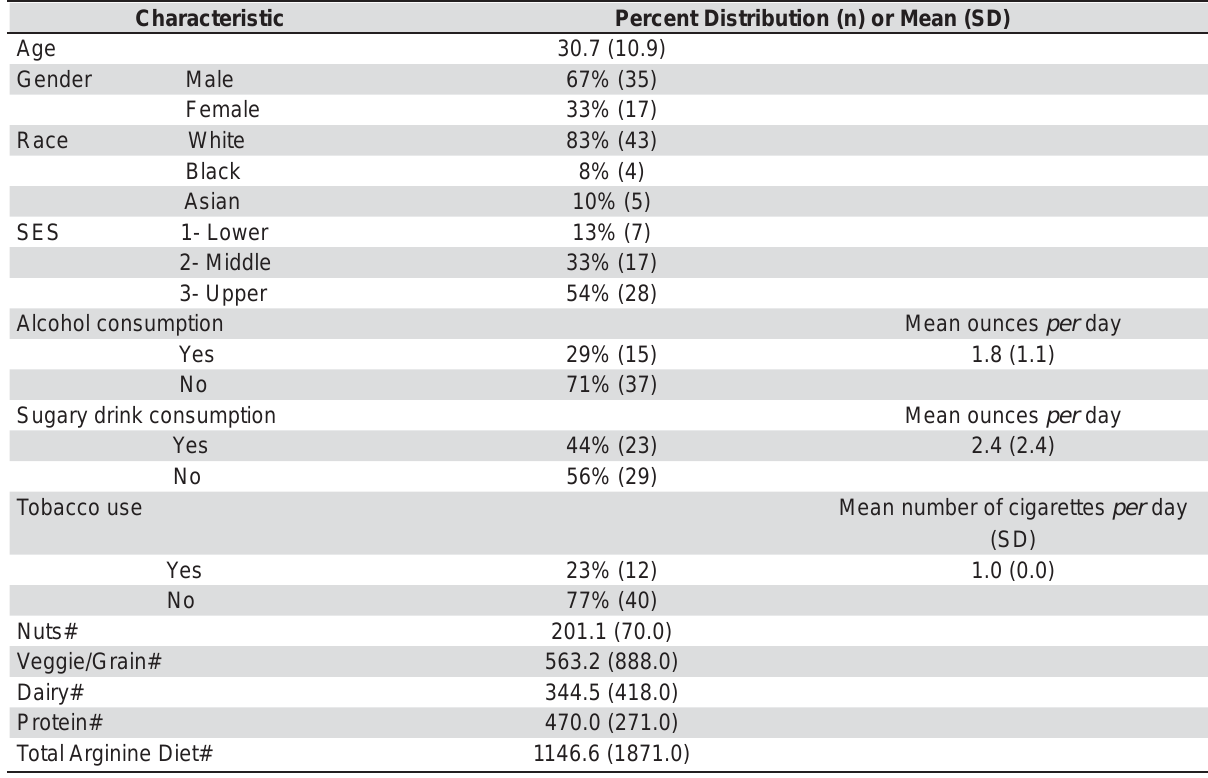
Table 1- Demographic distribution of the patients participating in the study